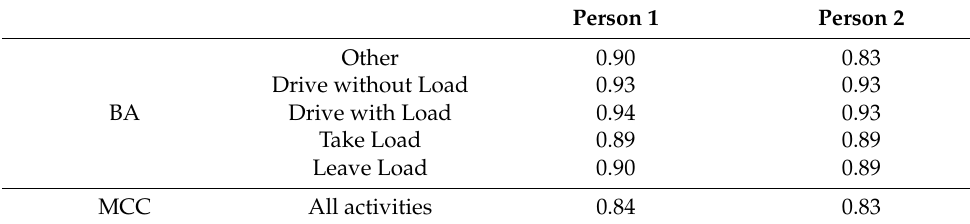
Table 4. Activity recognition results of two non-experts on the hold-out test set (using